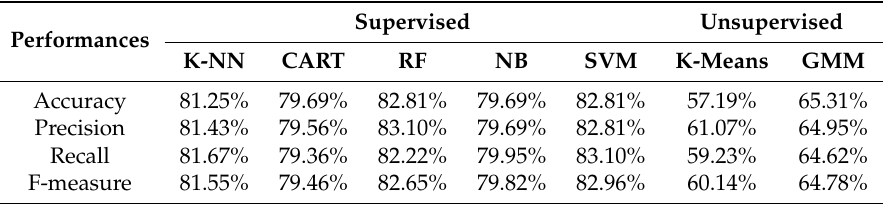
Table 7. Accuracy, Precision, Recall and F-measure for each classifier in the case of the Frenkel-Toledo et al.